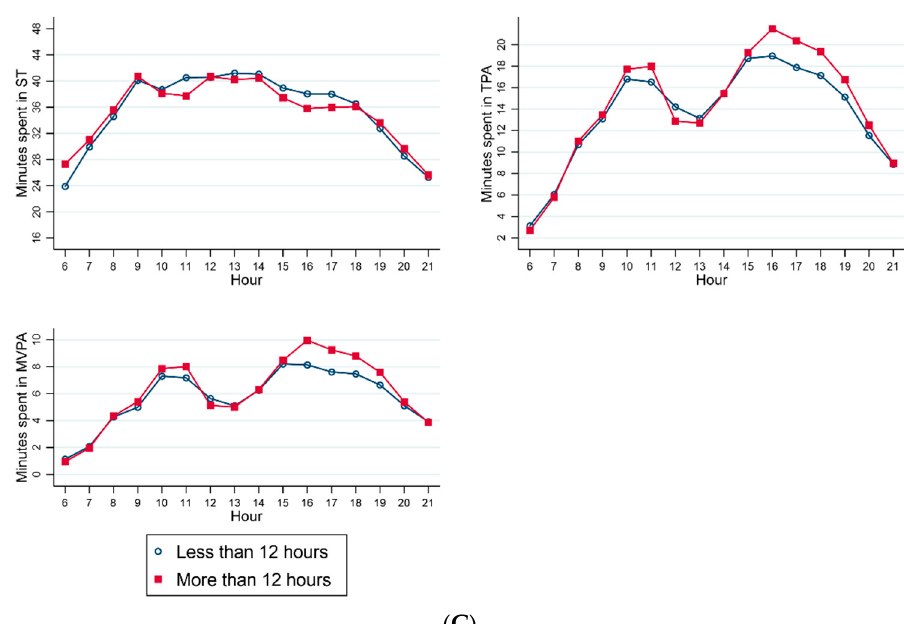
Figure 1. Mean minutes spent in sedentary time, total physical activity, and moderate-to-vigorous physical activity according to the hours of the day by ( A ) country, ( B ) day of the week (weekday vs.